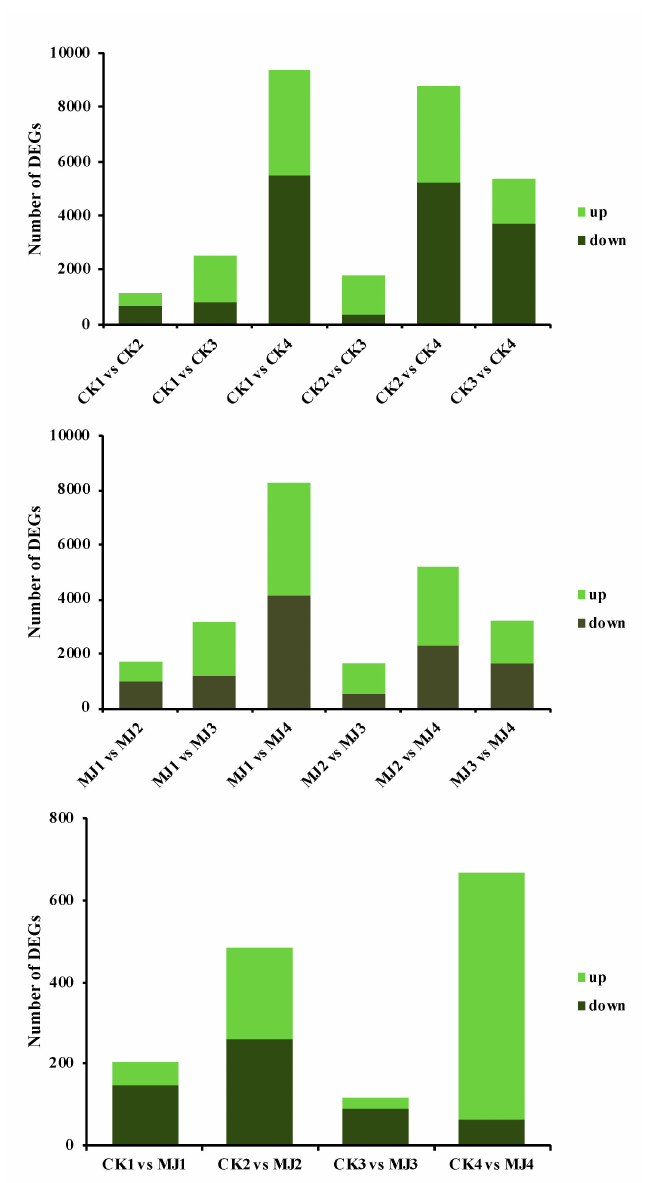
Figure 2. Comparison of the number of DEGs in CK and MJ200 seeds at different sampling